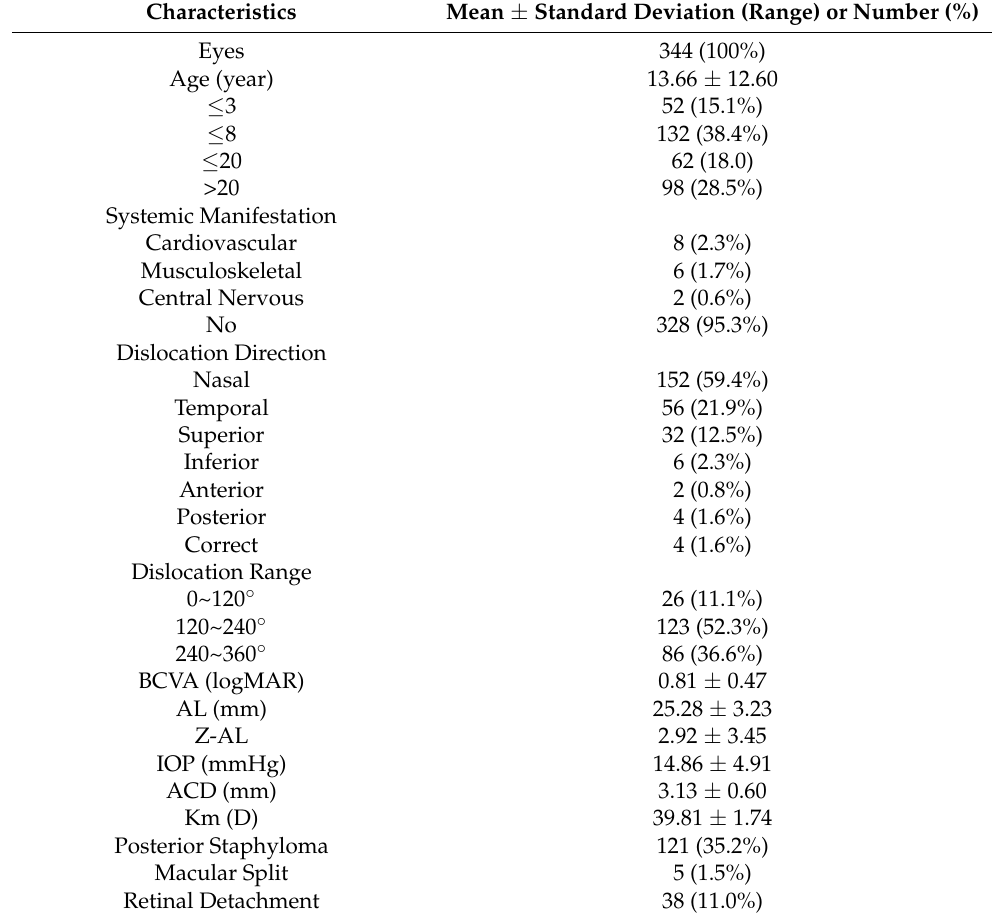
Table 1. The demographic status of the 172 participants with MFS.